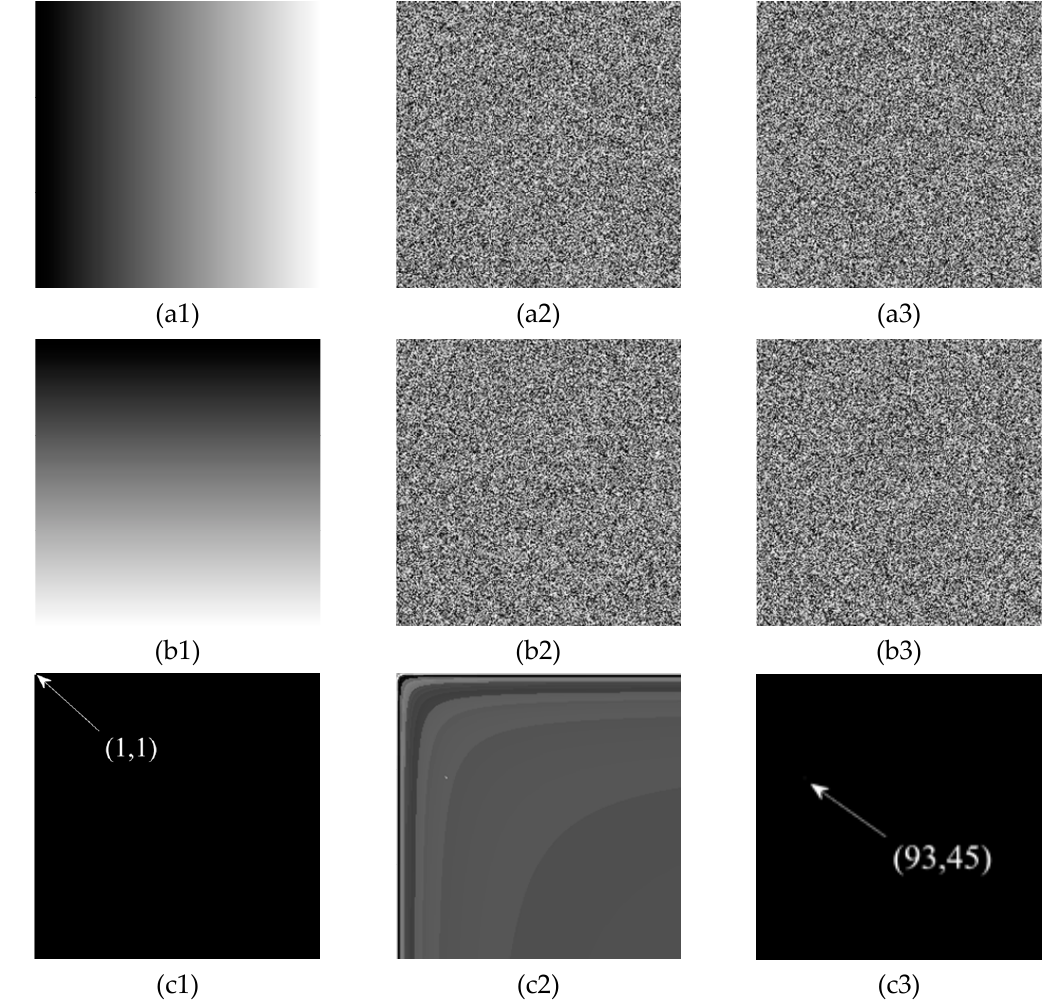
Figure 6. Chosen-plaintext attack for obtaining the permutation rule: images from the first column to the last are plain, cipher, and permutated images, respectively; images from the first row to the last are color, selected images, respectively.